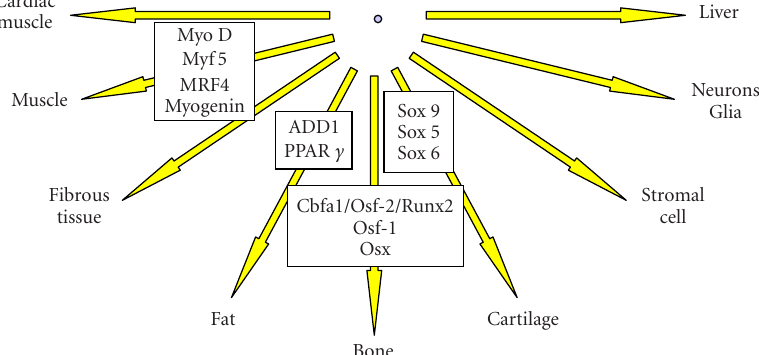
Figure 2. Di ff erentiation pathways for connective tissue progenitors. This diagram illustrates the potential di ff erentiation pathways available to connective tissue progenitor cells. Some of the transcription factors that regulate these pathways are shown in associated